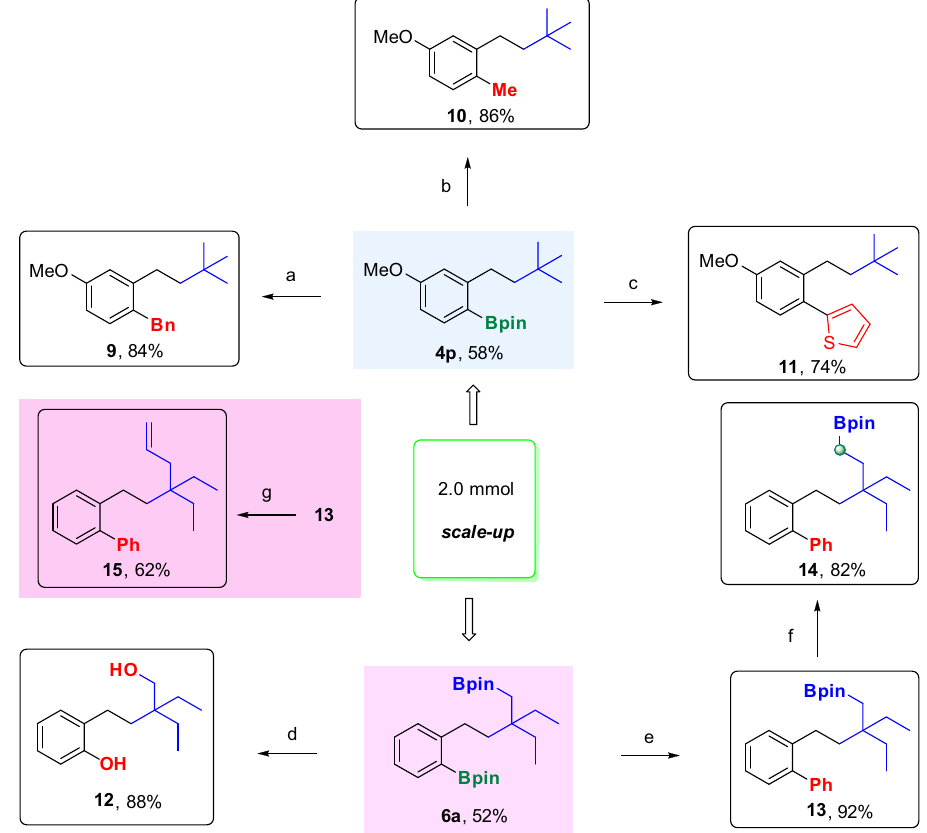
Fig. 5 Scale-up reactions and synthetic applications. a benzyl bromide, Pd(PPh 3 ) 4 , Cs 2 CO 3 , THF/H 2 O, 60 °C, 24 h; b methyl iodide, Pd 2 (dba) 3 , (2-tol) 3 P, K 2 CO 3 , DMF/H 2 O, 80 °C, 24 h; c − 78 °C, n- BuLi, thiophene, then rt, 1 h; − 78 °C, R-Bpin, 1 h; NBS, 1 h; d NaOH, H 2 O 2 , THF, 0 °C to rt, 4 h; e PhI, Pd(PPh 3 ) 2 Cl 2 , Cs 2 CO 3 , THF/H 2 O, 80 °C, 6 h; f ClCH 2 I, n -BuLi, THF, − 78 °C to rt; g vinylmagnesium bromide, I 2 in MeOH, − 78 °C to